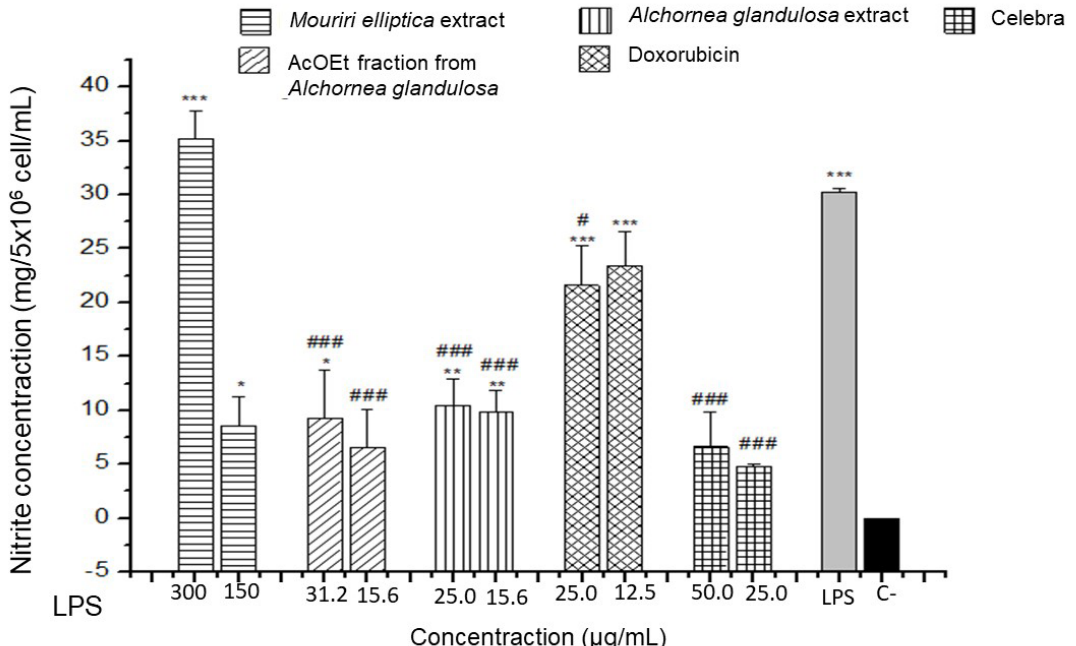
Figure 4. Determination of NO production/inhibition in culture of peritoneal macrophages of normal mice. LPS solution was used as positive control (LPS). As negative control (C-), only cells in culture medium (RPMI-1640-C) were used. The statistical analysis was performed through variance (ANOVA) using the Tukey post-test. *** P < 0.001, ** P < 0.01 and * P < 0.05 when compared to the negative control. ### P < 0.001, # P < 0.05 when compared to positive